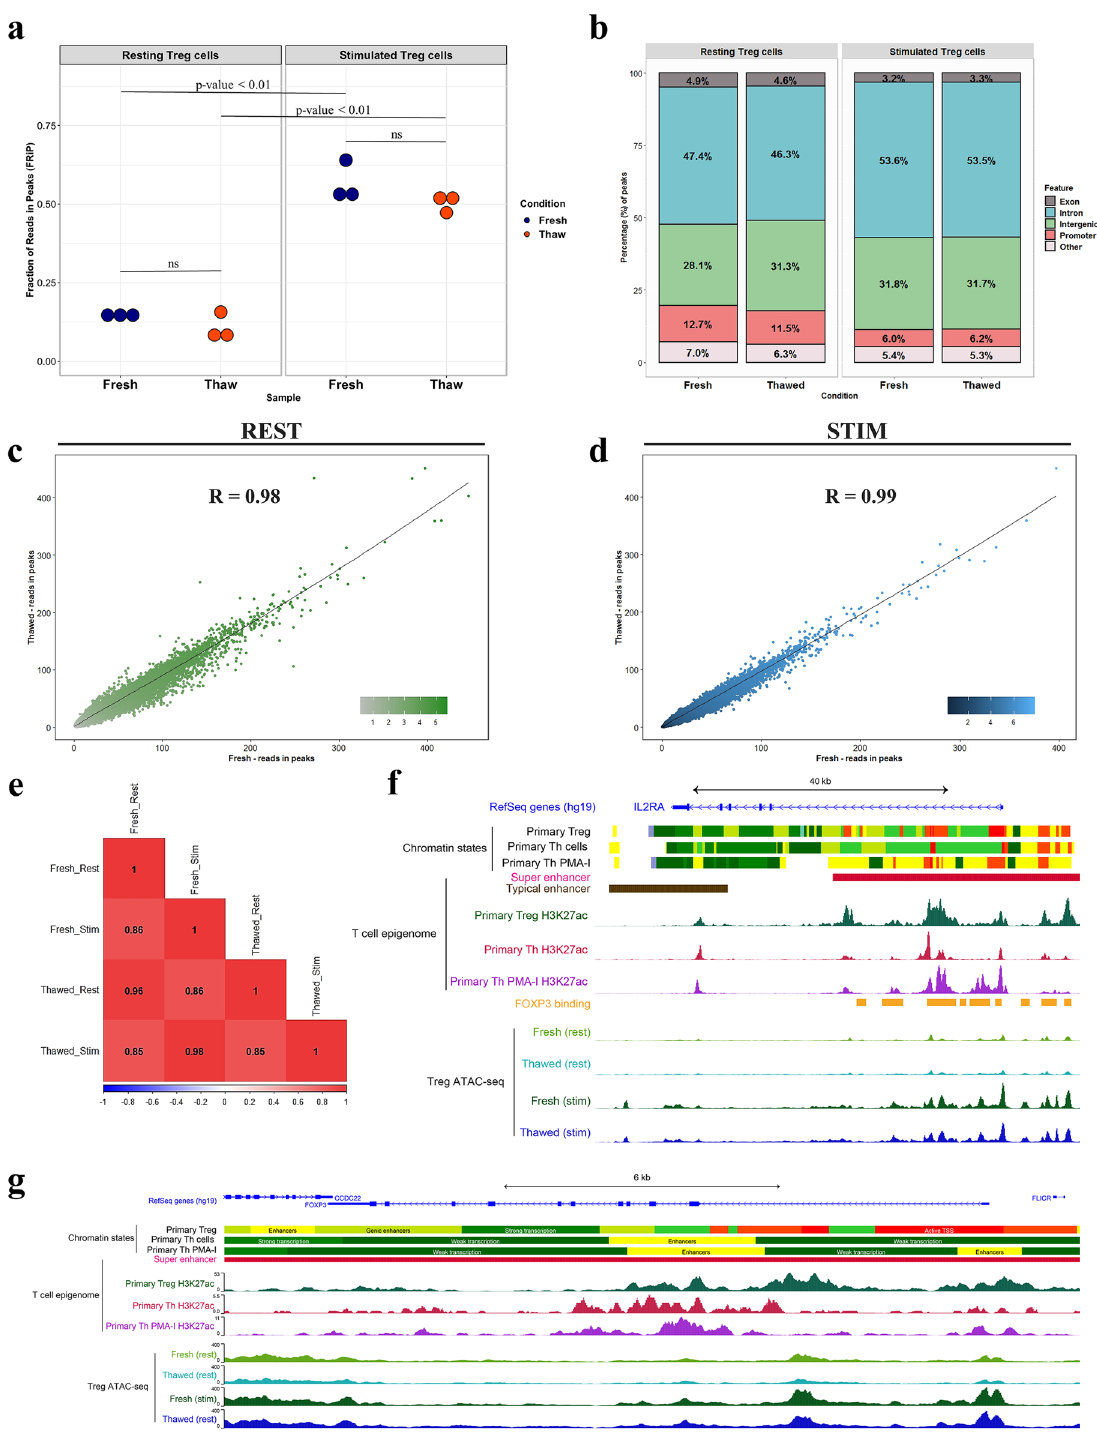
Figure 3. Chromatin accessibility is maintained through cryopreservation. ( a ) The fraction of reads in peaks for fresh and thawed Treg ATAC-seq libraries. Statistical significance of the difference between the fresh and thawed samples is computed by Paired Student’s t-Test. ( b ) Distribution of ATAC-seq peaks across distinct genomic feature expressed in proportion of annotated peaks. Promoters are defined by -1 kb to + 100 bp TSS region. Other, peaks annotated to 3’ UTR, 5’UTR, miRNA, non-coding RNA and TTS (transcription termination site). ( c , d ) Scatter plot of the read count per million (CPM) reads in ATAC-seq peaks identified from fresh and thawed samples during resting ( c ) and in response to stimulation (d). Pearson’s correlation coefficient value is indicated. ( e ) Correlogram showing the association of CPM reads for all the ATAC-seq samples generated for this study. ( f , g ) Chromatin accessibility profiles of fresh and thawed Treg cells during resting and stimulated state at the IL2RA ( f ) and FOXP3 ( g ) loci. ATAC-seq signal is intersected with T cell super enhancers, Treg chromatin states from Roadmap Epigenomics Project and FOXP3 binding sites. Each ATAC-seq track represents signal pooled from three donors. Browser view was generated using UCSC genome browser. The calculation for a-g was performed on pooled data representative of three